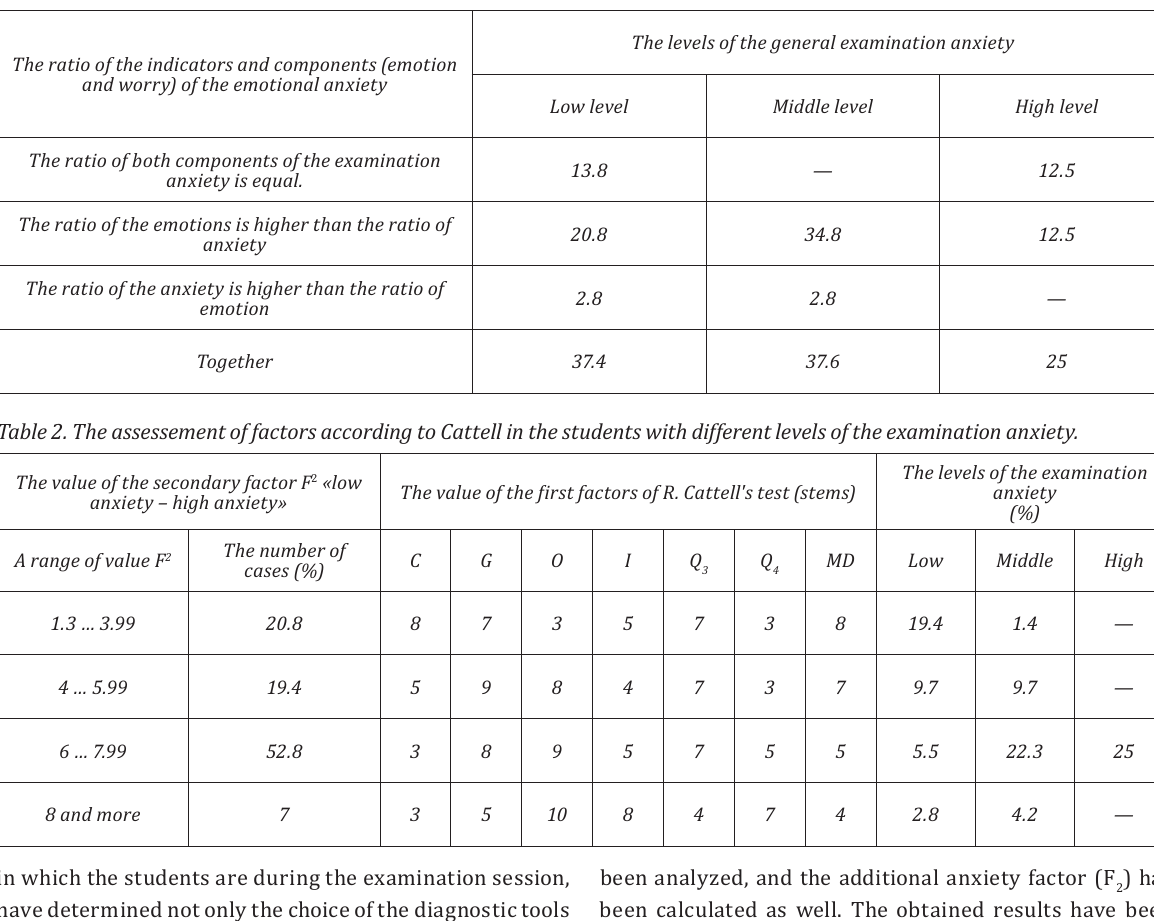
Table 1. The ratio of the examination anxiety level and some of its components among studens (%).